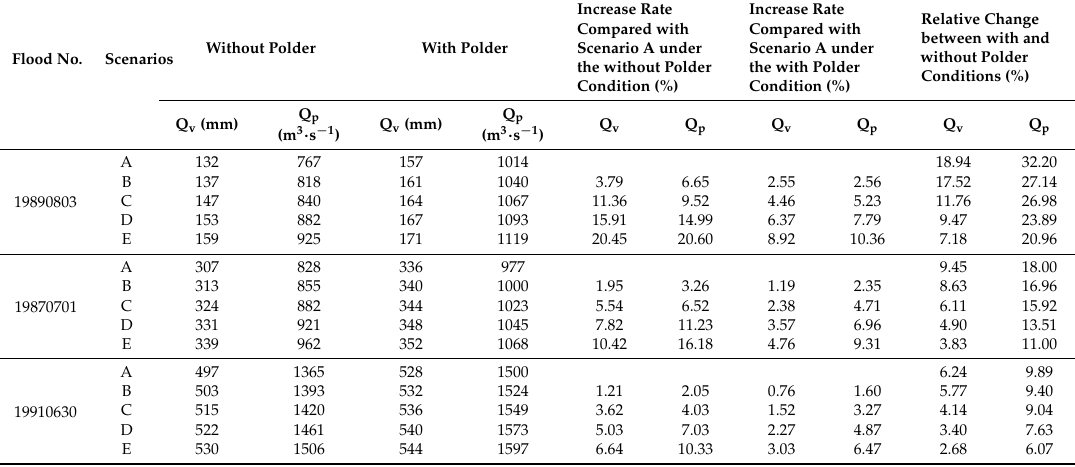
Table 6. Hydrological response to urbanization under with and without polder conditions. Without Polder With Polder Flood No. Scenarios